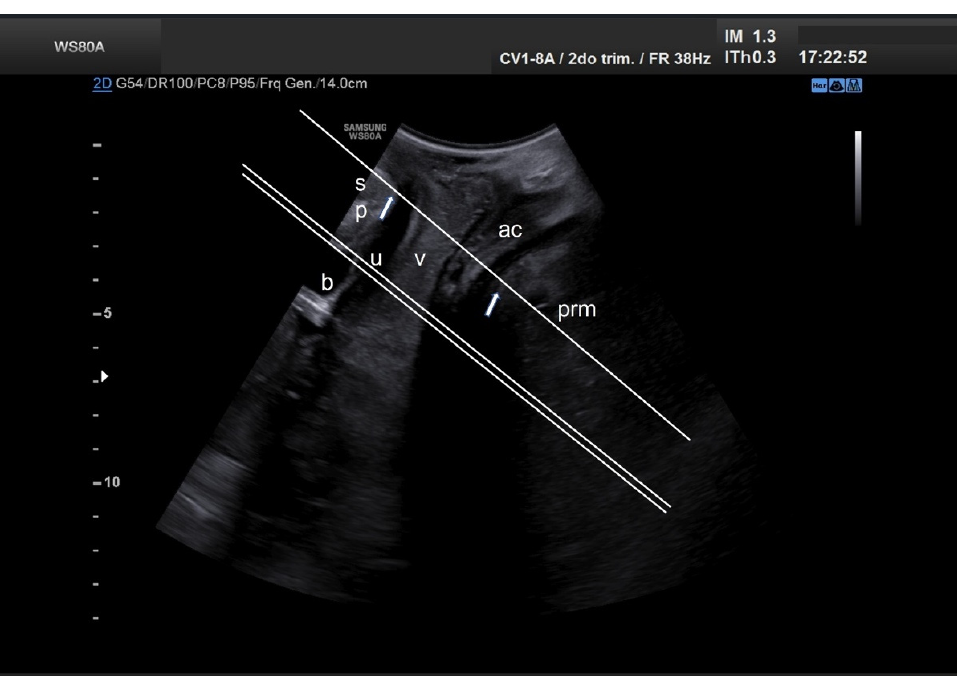
Figure 1. Mid-sagittal translabial two-dimensional pelvic floor ultrasound, showing the location of planes used for determining hiatal diameters and areas (single line) as well as pubovisceral muscle thickness and area (double line). ac, anal canal; b, bladder; prm, puborectalis muscle; sp, pubic symphysis; u, urethra; v, vagina.